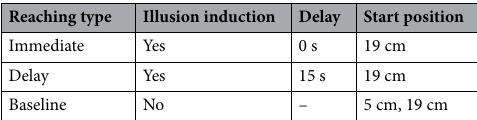
Table 1. Experimental parameters for each reaching